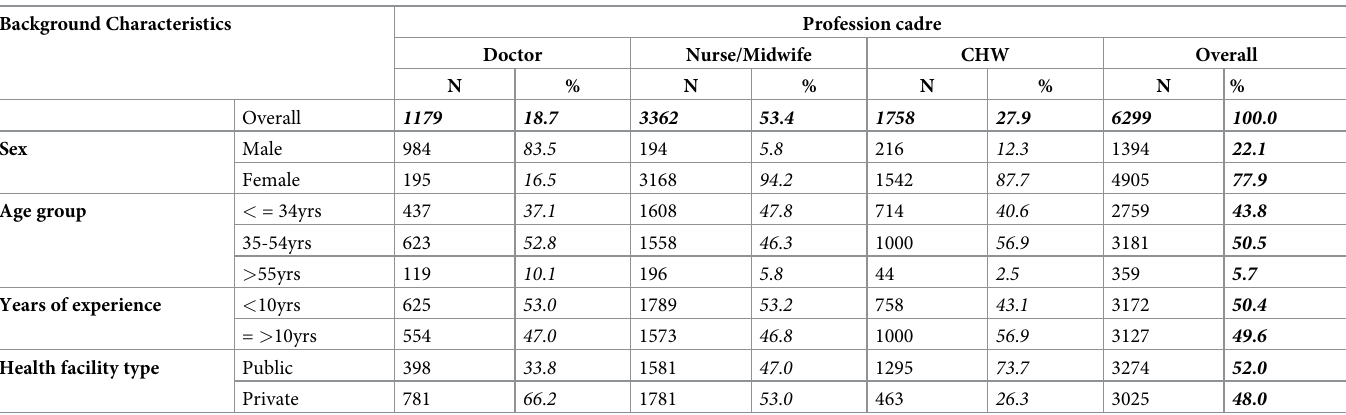
Table 1. Background characteristics of